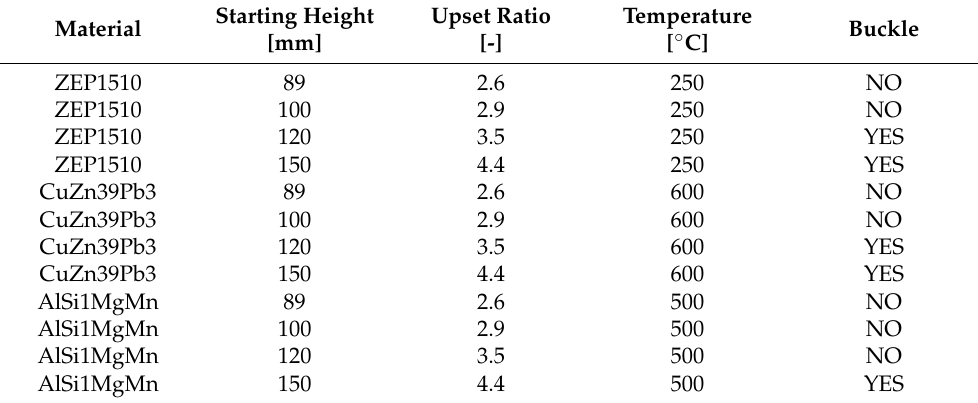
Table 3. Results of the tests for the determination of the upset ratio.